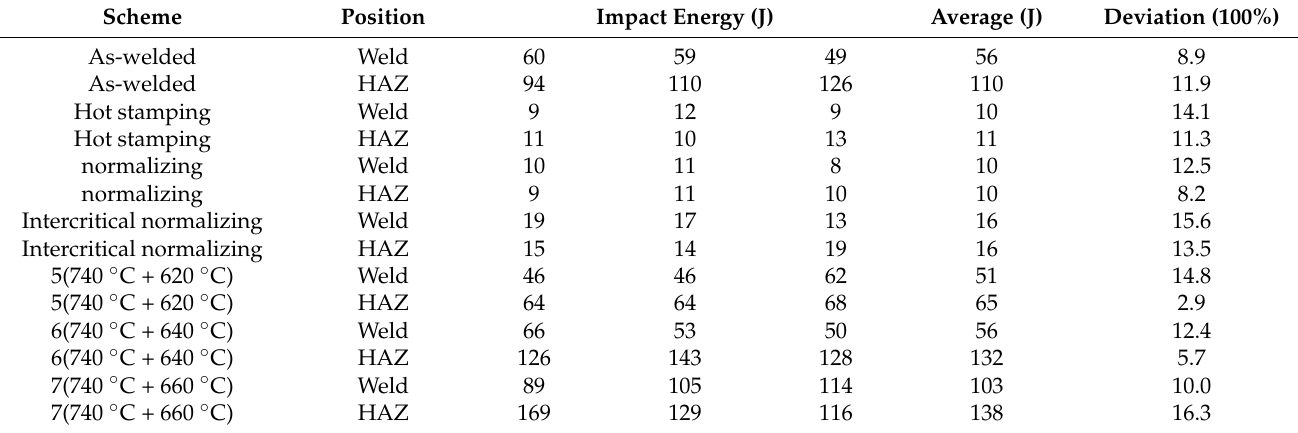
Table 7. The impact toughness of weld and HAZ in as-welded, hot stamping, normalization, intercritical normalization, tempered at 620 ◦ C, 640 ◦ C, and 660 ◦ C,